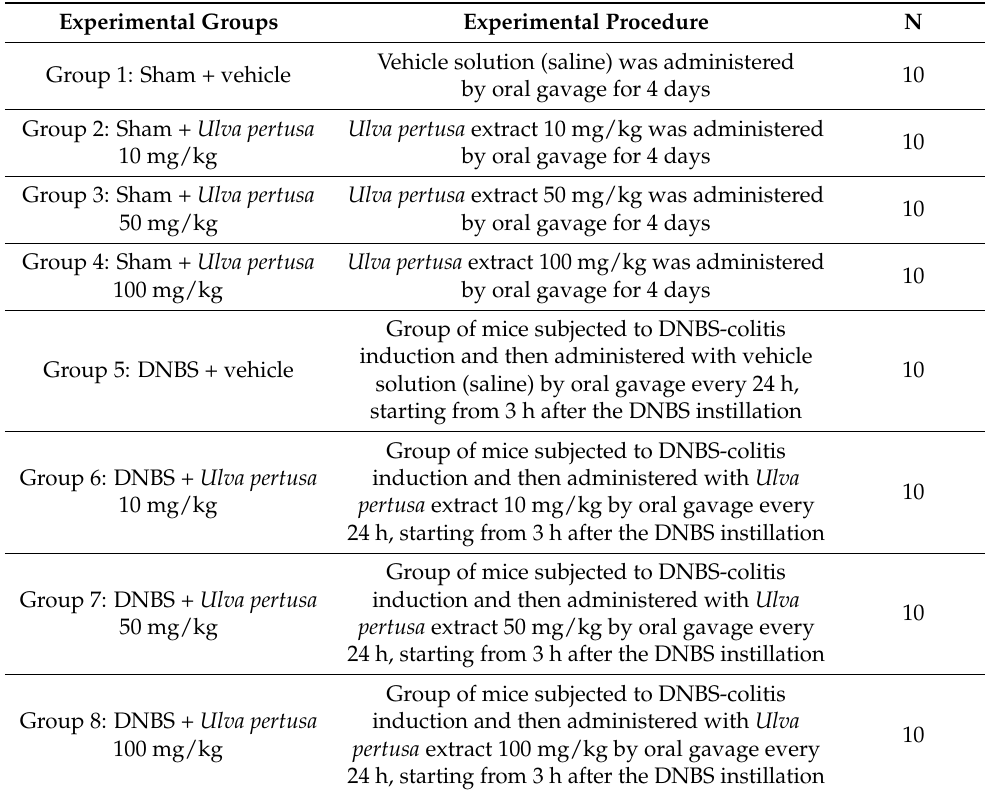
Table 1. Experimental groups and procedure of the